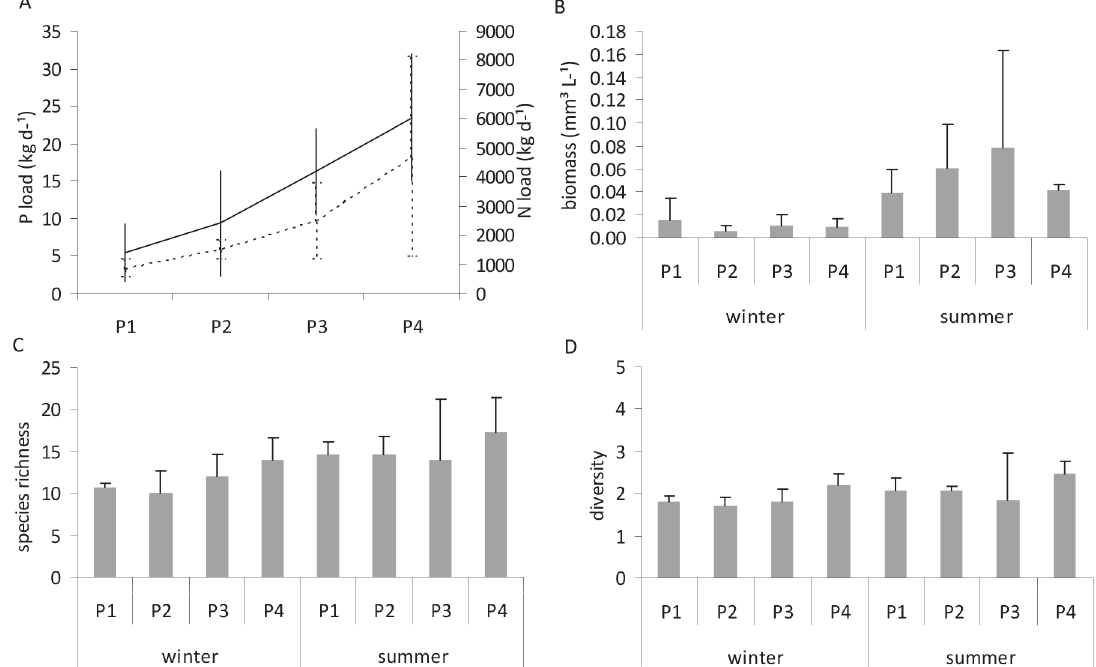
Figure 2 - Phosphorus (P load, kg.d -1 ) and nitrogen loads (N load,kg.d -1 ) (A), biomass (mm³.L -1 ) (B), species richness (number of individuals) (C) and diversity (mg.ind -1 ) (D) estimated for each sampled point (P1 = most preserved; P4 = less